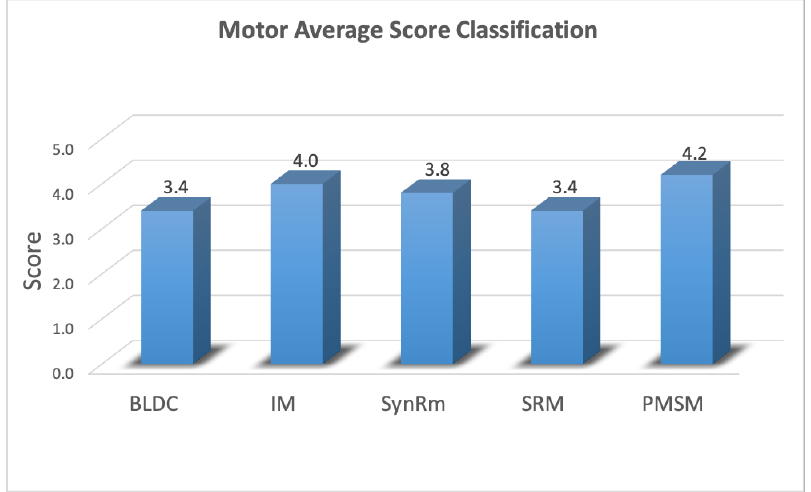
Figure 17. Classification and average score of different motors.